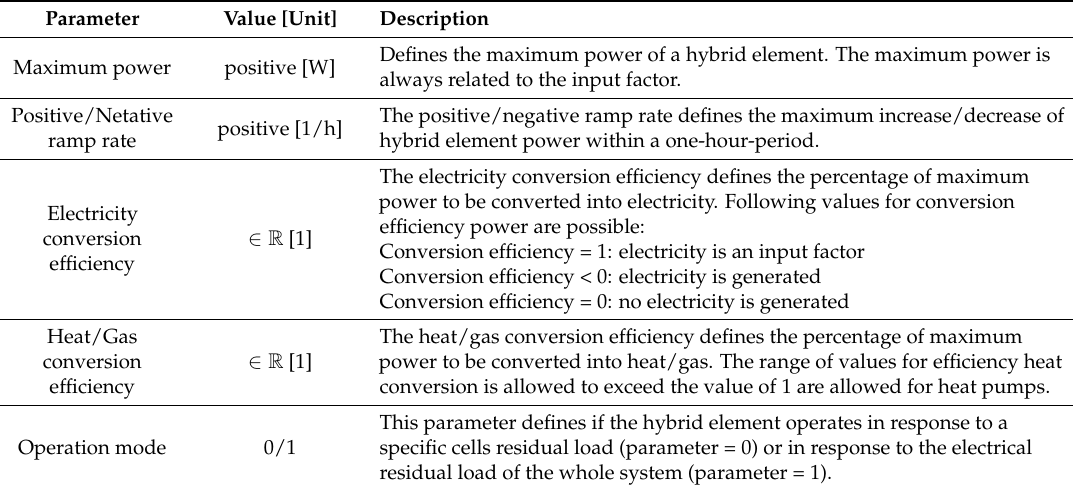
Table 2. Characterization parameters for hybrid elements.